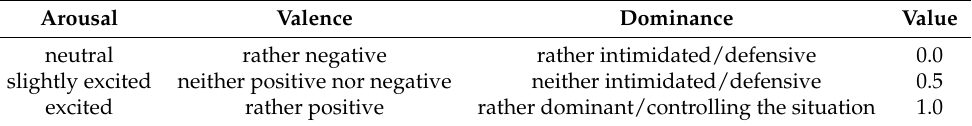
Table 4. Transformation of the answers to the VAD questions into continuous values in the range [0, 1]. Later, the means of the transformed values of the five annotators were computed to obtain continuous values for the dimensional model.